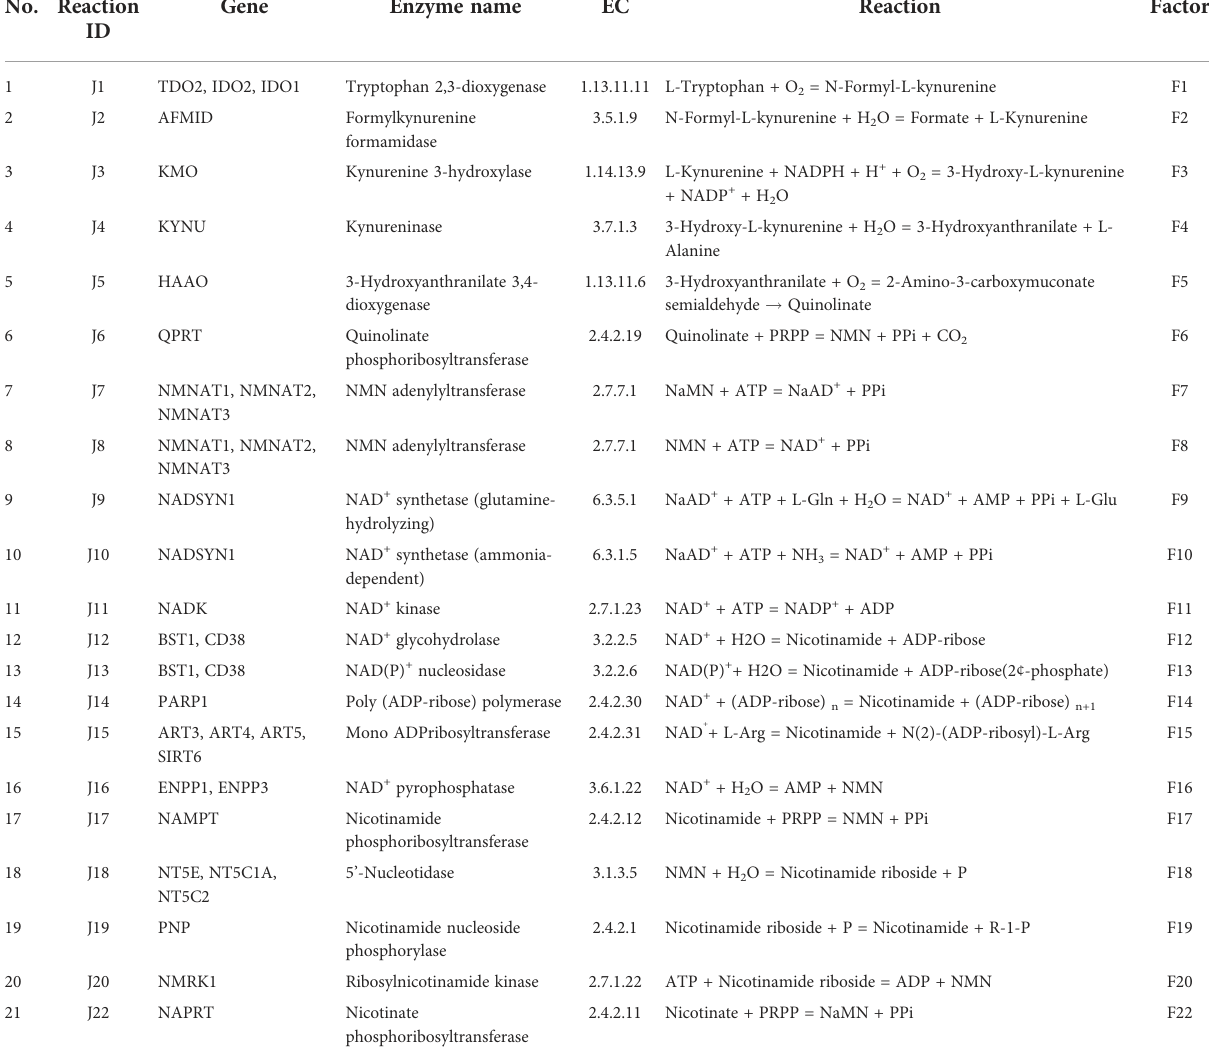
TABLE 1 NAD net pathway reactions to gene, enzyme, and Factor mappings information. No. Reaction